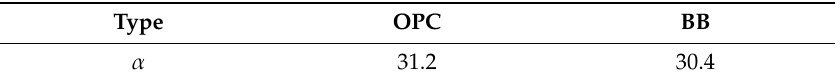
Table 6. Experimental coe ffi cients ( α ).